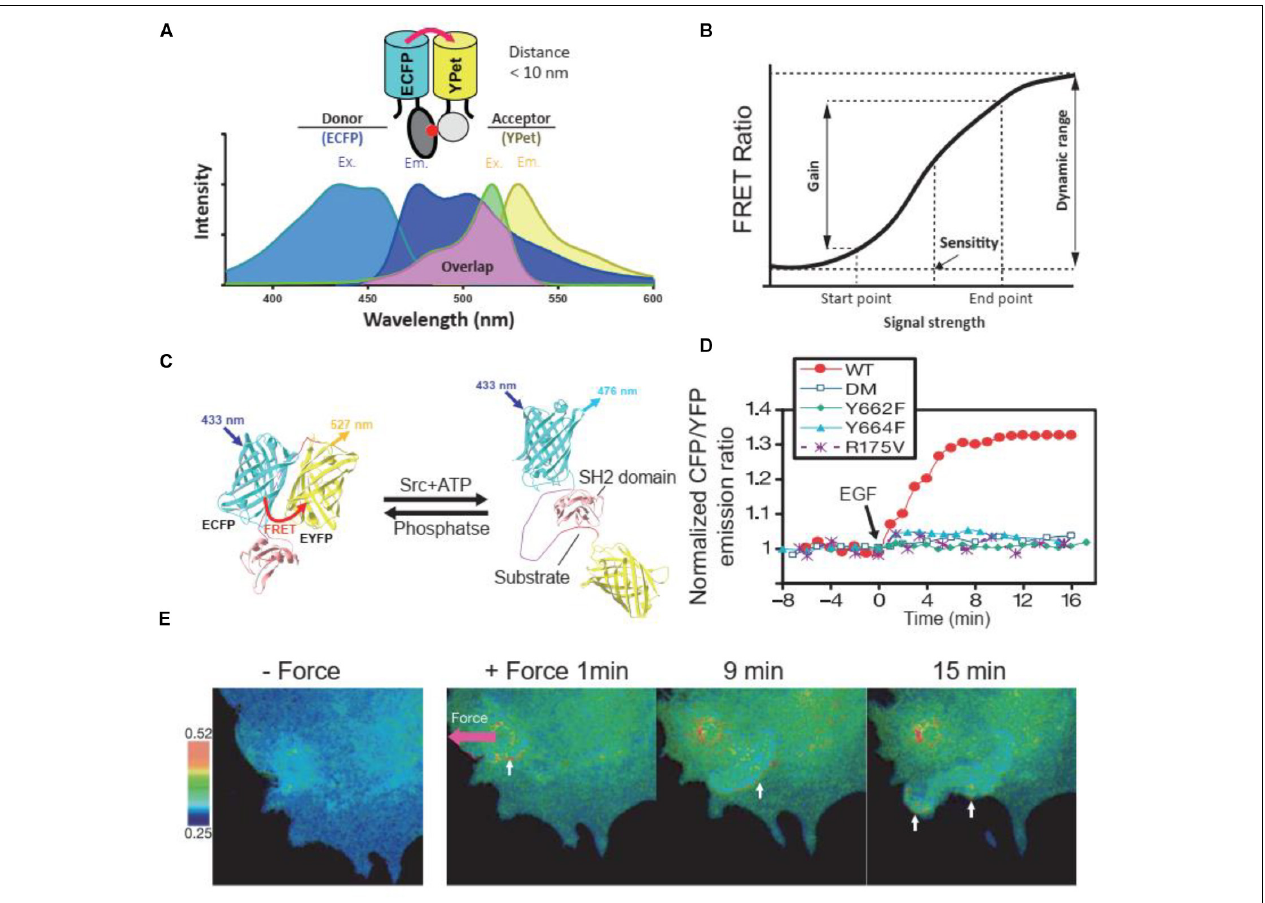
FIGURE 1 | FRET principles and FRET biosensors. (A) Excitation (Ex.) and Emission (Em.) wavelength of ECFP and YPet, as a FRET donor and receptor, respectively. The emission wavelength of ECFP overlaps with the excitation wavelength of YPet, enables the energy transfer between donor and receptor when their distance is less than 10 nm. (B) The terminology used to describe and quantify the performance of FRET biosensors. The figure was modified based on previous publication (Komatsu et al., 2011). (C) The cartoon illustrates the FRET change of a Src kinase biosensor at the presence of Src kinase or phosphatase. (D) Time course quantification of the Src FRET biosensor and its loss of function mutants in response to EGF stimulation in HeLa cells. Y662F and Y664F, single loss-of-function mutations in the substrate of the biosensor; DM, double mutation (Y662F and Y664F); R175V, loss-of-function mutation in SH2 domain. (E) FRET responses of a cell with clear directional wave propagation away from the site of mechanical stimulation. In these images, a pulling force was applied via laser tweezers on a bead coated with fibronectin on the cell membrane. (C–E) were obtained from a previous publication (Wang et al.,